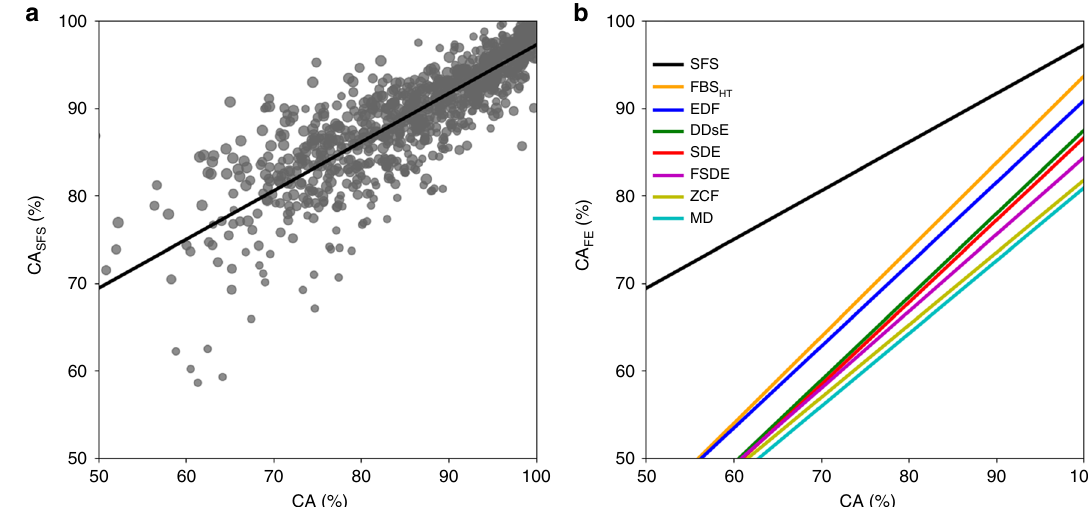
Fig. 7 CA – CA plots. a Bayes CA in salient feature space vs. Bayes CA without dimension reduction. b Regression lines for the feature extraction methods reported in Fig. 6. Given the fact that all the feature extraction/selection methods are followed by the same classi fi er, the CA – CA plot in b provides a fair basis for the comparison of the proposed salient feature strategy with other feature extraction/selection approaches. The top-most regression line in this plot belongs to the proposed approach. Exhibiting the highest possible classi fi cation accuracy (CA FE ∣ CA = 100%) and at the same time the lowest slope among all approaches is an indication of the absolute superiority of the proposed salient feature selection idea over all other existing approaches in the